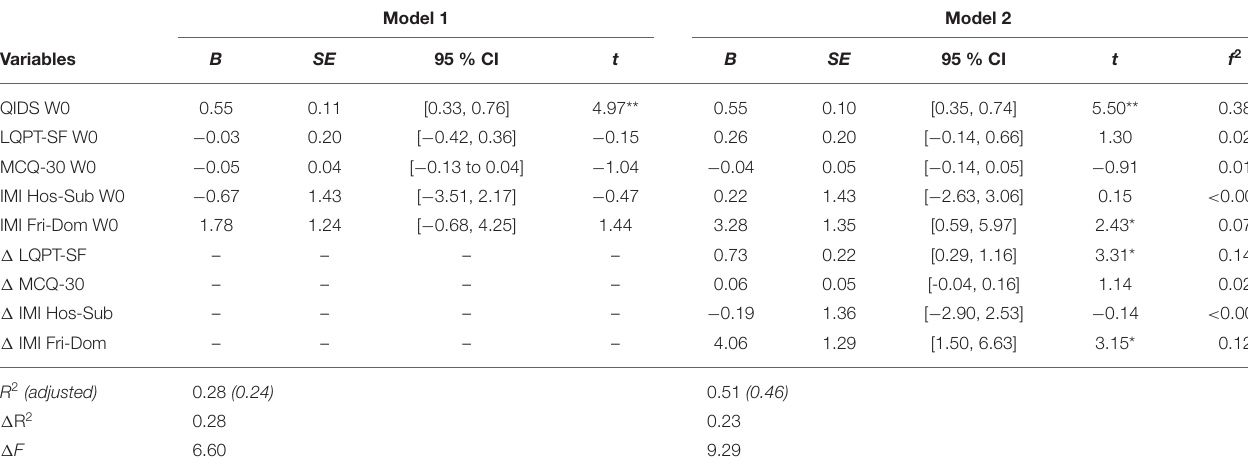
TABLE 3 | Regression analysis. Model 1 Model